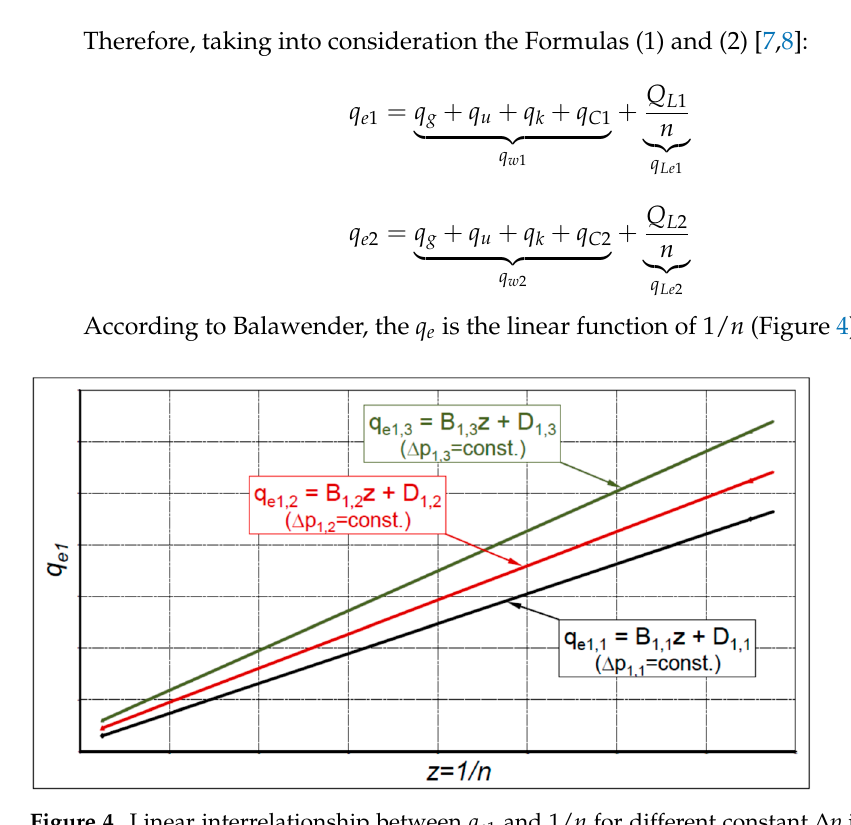
Figure 4. Linear interrelationship between q e 1 and 1/n for different constant  p in the motor for flowmeter Q 1 (Figure 1) [8].